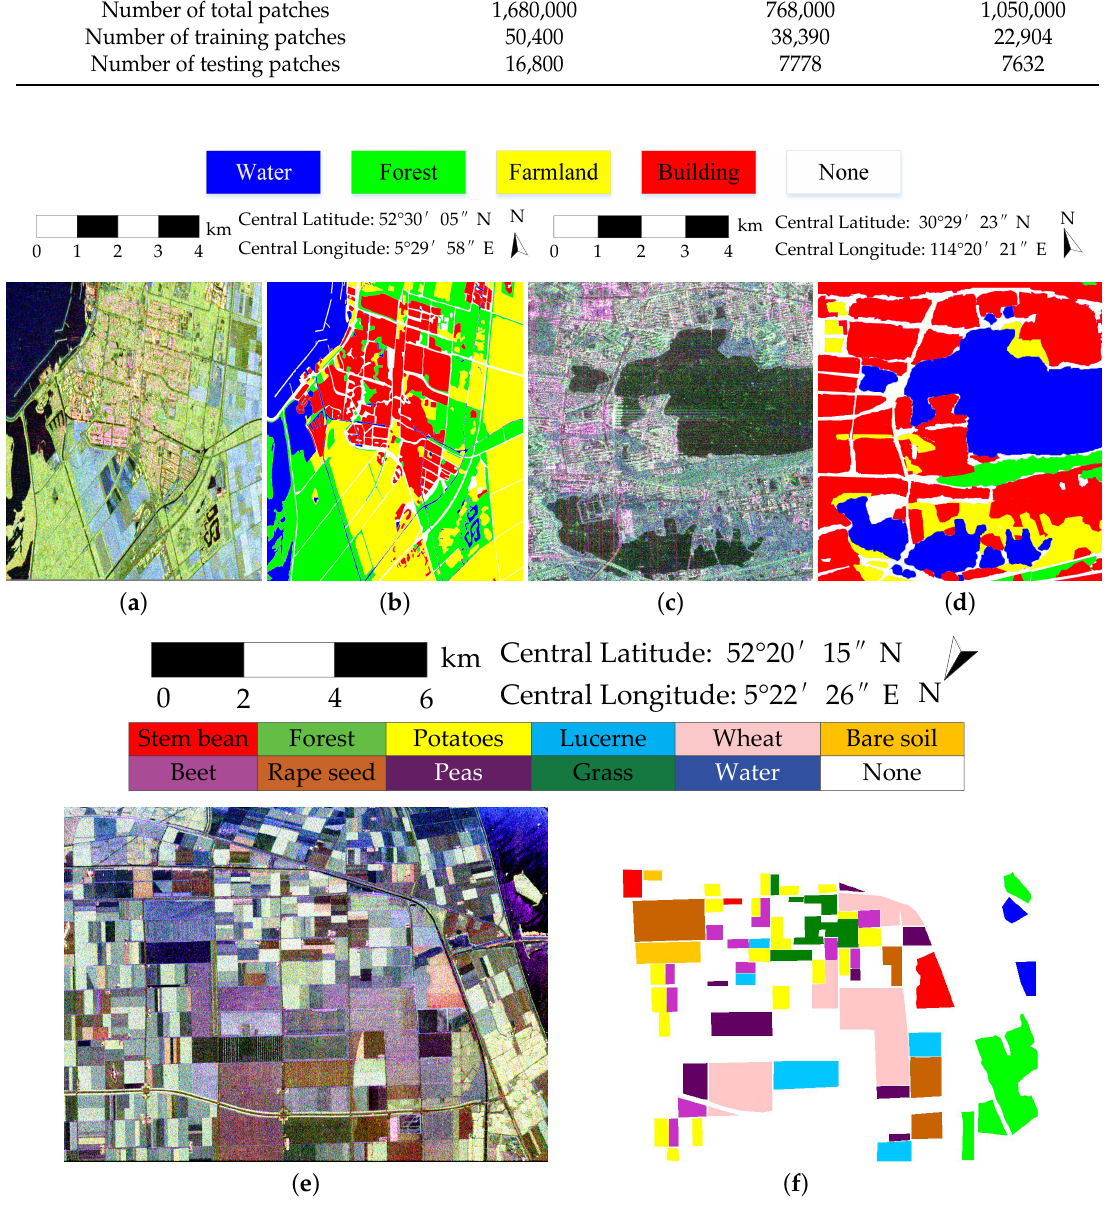
Figure 6. PolSAR images and the ground truth maps for land cover classification. ( a ) Pauli RGB image of RS-2 Flevoland; ( b ) Ground truth map of RS-2 Flevoland; ( c ) Pauli RGB image of GF-3 Wuhan; ( d ) Ground truth map of GF-3 Wuhan; ( e ) Pauli RGB image of AIRSAR Flevoland; ( f ) Ground truth map of AIRSAR